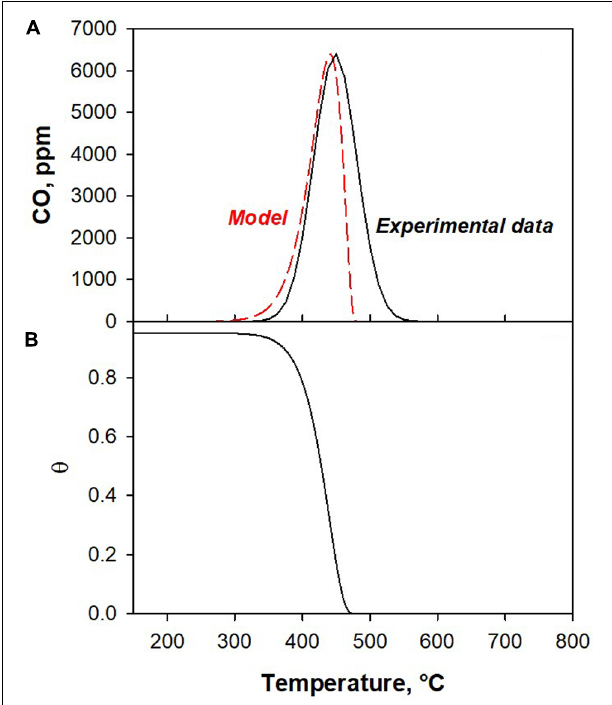
FIGURE 4 | (A) Experimental and model H 2 production (low temperature peak, bare H 2 O splitting) and (B) the corresponding surface site evolution calculated by the kinetic model. TABLE 3 | Kinetic parameters of surface splitting